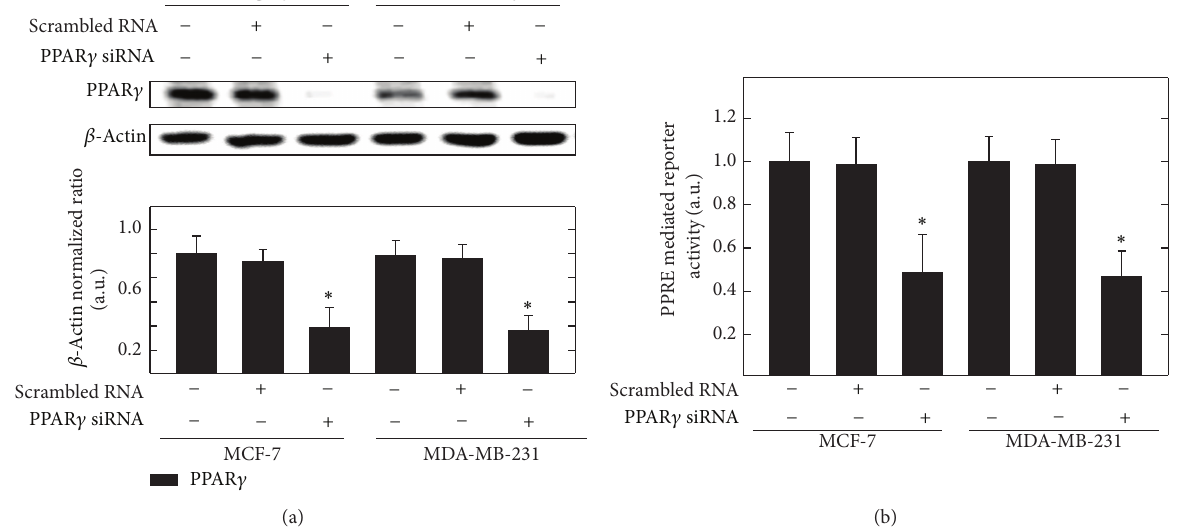
Figure 7: (a) Western blot analysis and (b) luciferase assay to determine expression and activity of PPAR 𝛾 in PPAR 𝛾 siRNA transfected MCF- 7 and MDA-MB-231 cells. For Western blot, cells were plated at a density of 2 × 1 0 5 cells/well (3 replicates per group) in 6-well plates in 2 mL antibiotic free media. Transfections were performed using 5 𝜇 L lipofectamine 2000 according to the manufacturer’s protocol. For western blot analysis, whole cell lysates were prepared from each treatment group for subsequent separation by polyacrylamide gel electrophoresis (50 𝜇 g/lane). Scanning densitometric analysis was performed on all the blots done in triplicate and the integrated optical density of each bond was normalized with corresponding 𝛽 -actin, as shown in bar graphs below their respective Western blot images. Vertical bars in the graphs indicate the normalized integrated optical density of bands visualized in each lane ± SEM (arbitrary unit). For luciferase assay, cells were plated at a density of 2 × 1 0 4 cells/well (3 replicates per group) in 96-well plates. After this cells were transfected with 32 ng of PPRE X3-TK- luc and 3.2 ng of Renilla luciferase plasmid per well and then cotransfected with scrambled or PPAR 𝛾 siRNAs using 0.8 𝜇 L of lipofectamine 2000 transfection reagent for each well. After 6h transfection, the media were removed; the cells were washed once and exposed to 100 𝜇 L of control media. Afterwards, cells were lysed with 75 𝜇 L of passive lysis buffer and treated according to manufacturer’s instructions using dual-glo luciferase assay system. Results were calculated as raw luciferase units divided by raw Renilla units. Vertical bars indicate PPRE mediated reporter activity ± SEM (arbitrary unit). ∗ 𝑃 < 0.05 as compared with vehicle-treated